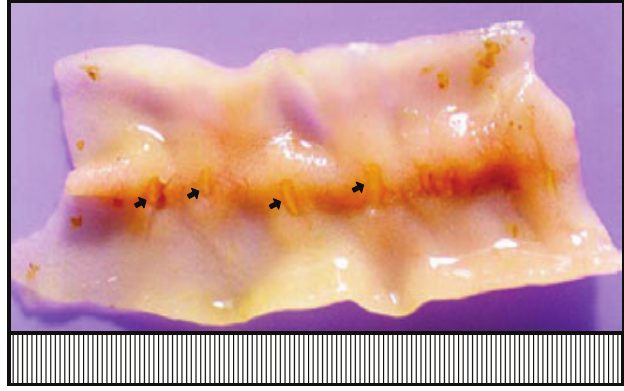
FIGURE 2 - Group II – Day 4. Mucosal side of the small intestine with ulcerated lesions in the mesenterial border.